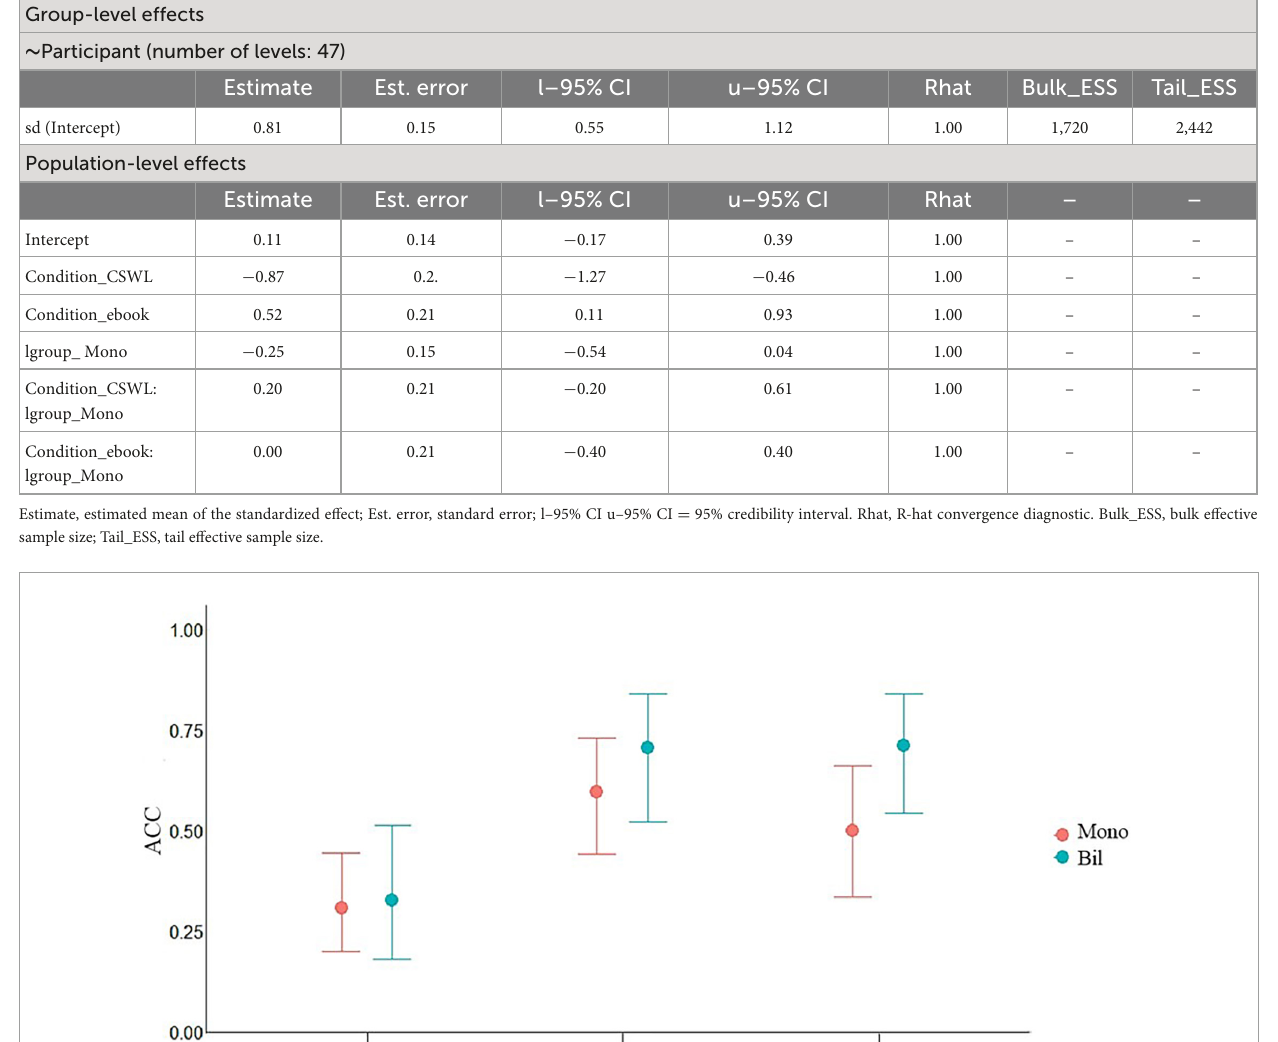
Mulak et al., 2019). Our results therefore extend those of Vlach and Sandhofer (2012) in a conclusive way, as the present study was conducted with four novel words instead of